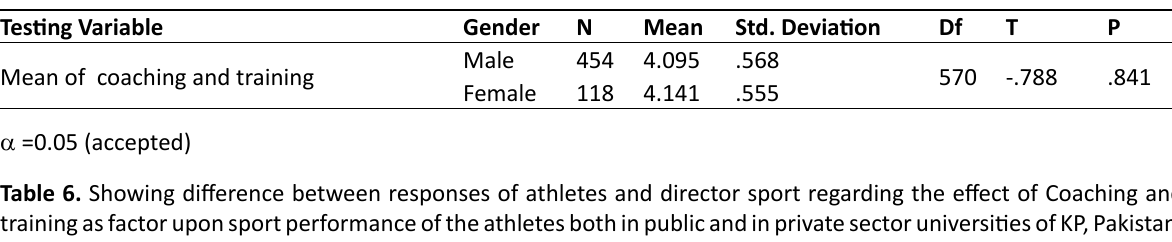
Table 5. Showing Gender wise (Male & Female) difference regarding the effect Coaching and training as factor upon sport performance of the athletes both public and private sector universities of KP, Pakistan.